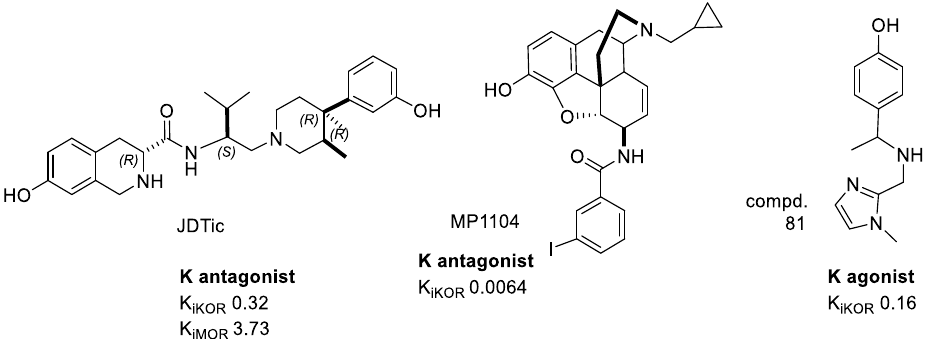
Figure 8. Examples of selected KOR ligands of interest for structural studies: the antagonist JDTic and the agonists MP1104 and compd. 81. K i values are also shown